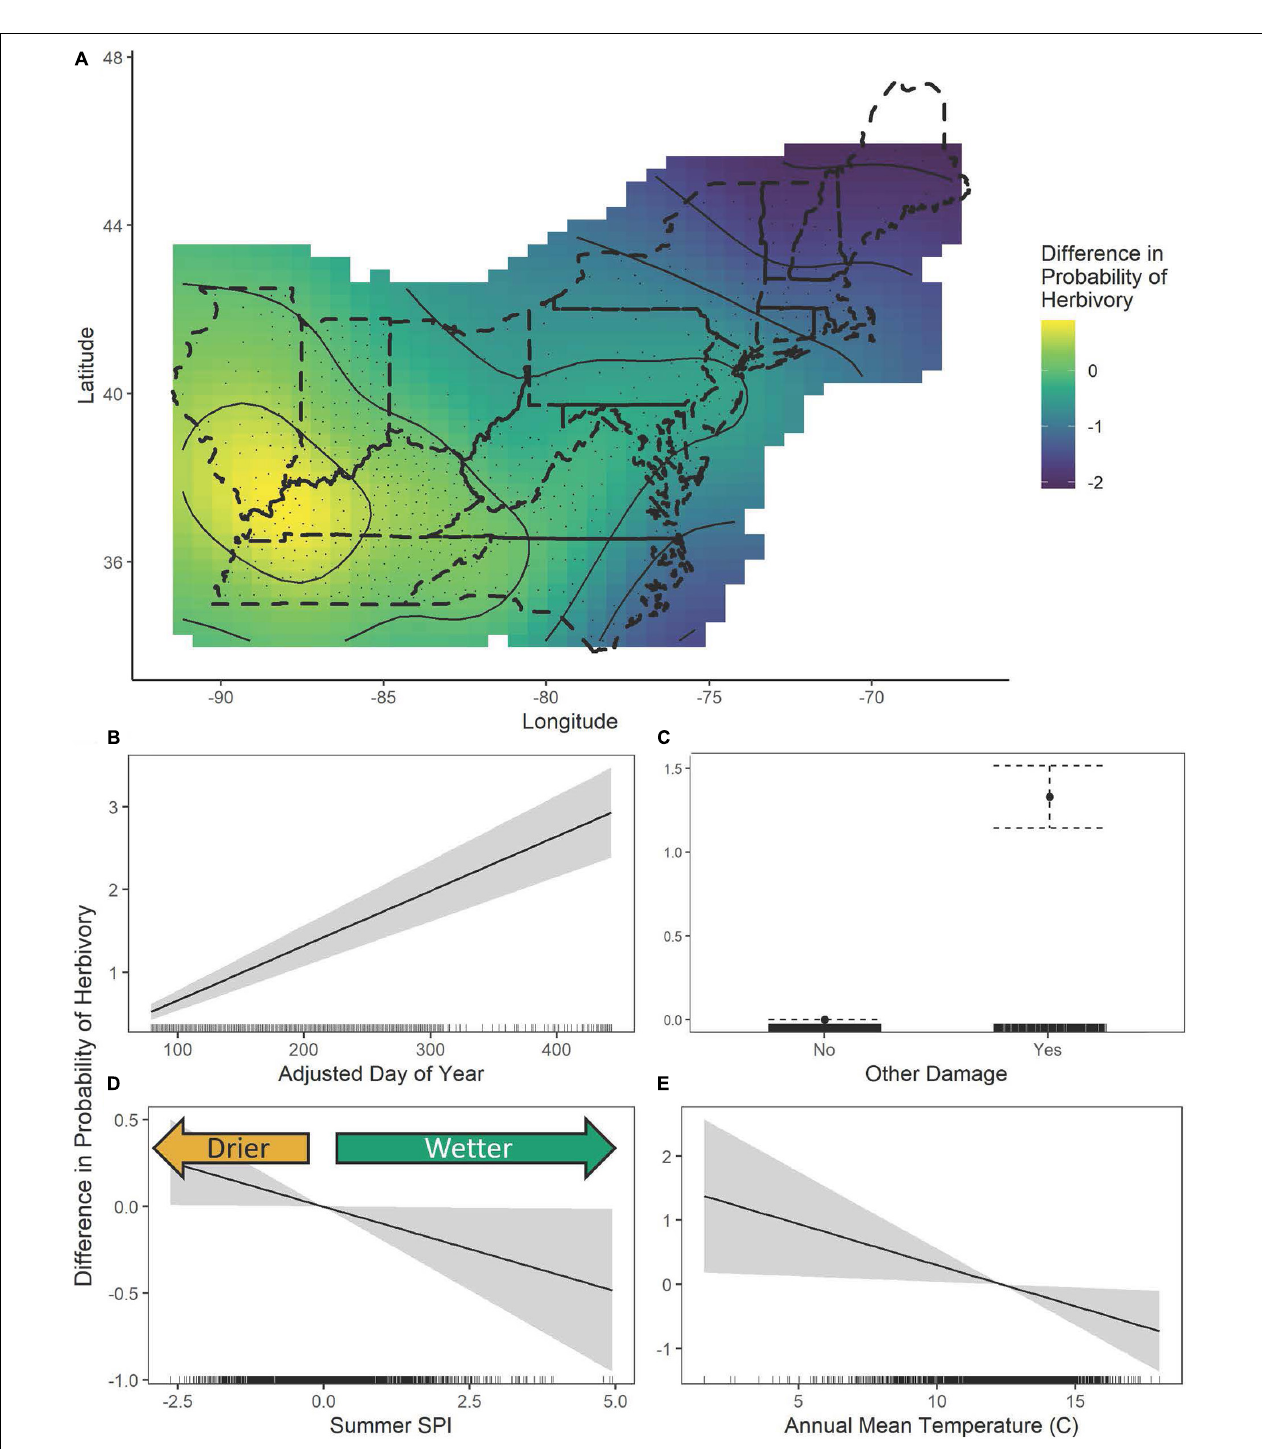
FIGURE 8 | The estimated contributions of the fitted smooths of latitude and longitude (A) , the adjusted day of year (B) , other damage (C) , SPI summer (D) , and the annual mean temperature (E) to the General Additive Model of the probability of herbivore damage. In figure (A) , the dashed lines show the United States state boundaries in the included regions, while the solid lines show the fitted smoothed curves output from the GAMs overlaid with the fitted contour showing spatial differences in the probability of herbivory. In figures (B,D,E) the solid curve while the gray regions or dotted whiskers represent the 95% confidence interval and in figure (C) the solid point shows the estimated contribution while the dotted lines show the 95% confidence interval. tick marks along the x-axis indicate the density of specimens.